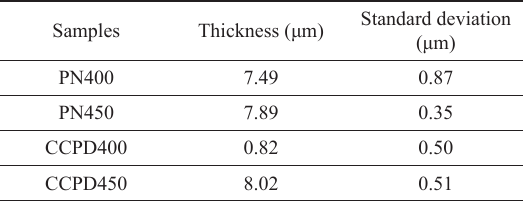
Table 2. Mean and standard deviation layer thicknesses of samples with conventional nitriding and cathodic cage nitriding.